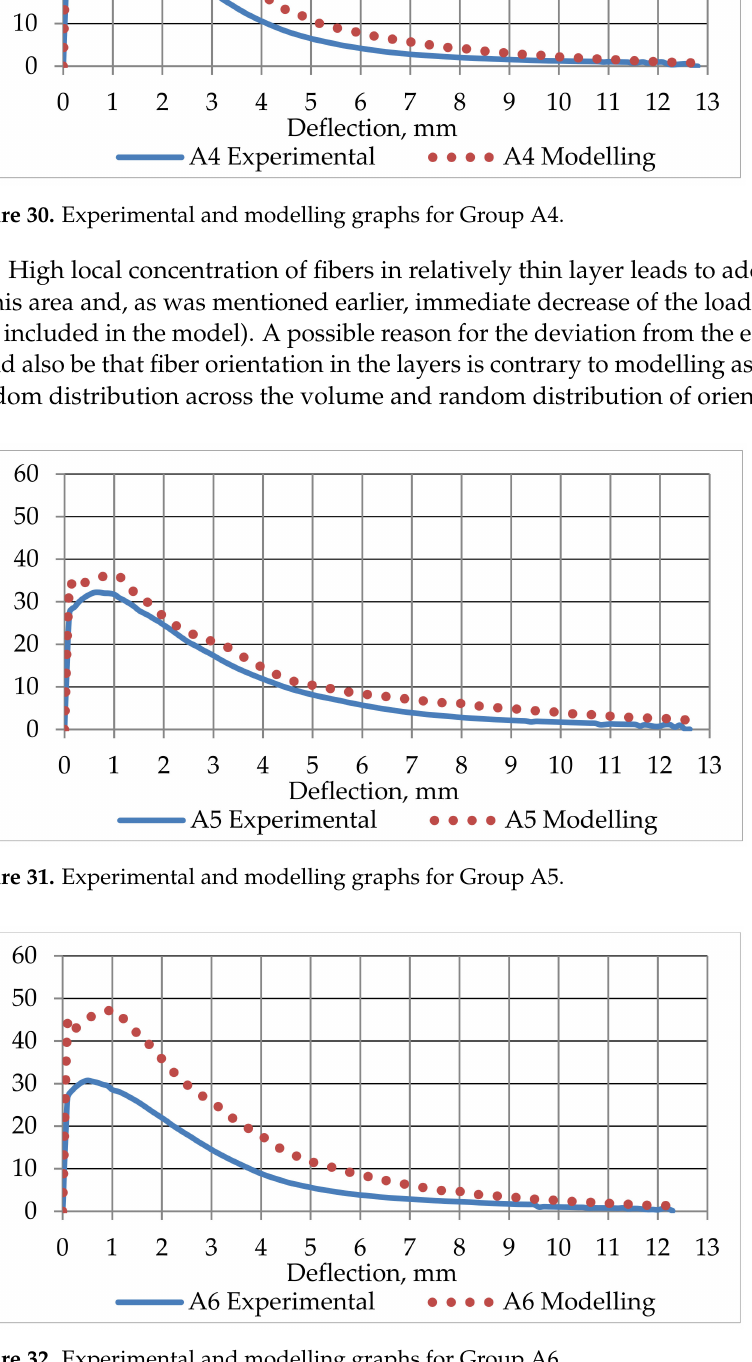
Figure 32. Experimental and modelling graphs for Group